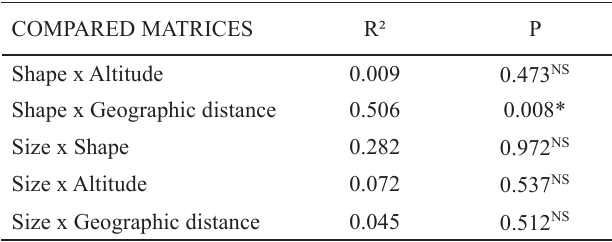
Table 3. Mantel test used to compare matrices of shape, size, altitude, and geographic distance, based on wing measurements of Melipona subnitida with 5,000 permutations. NS not significant; *